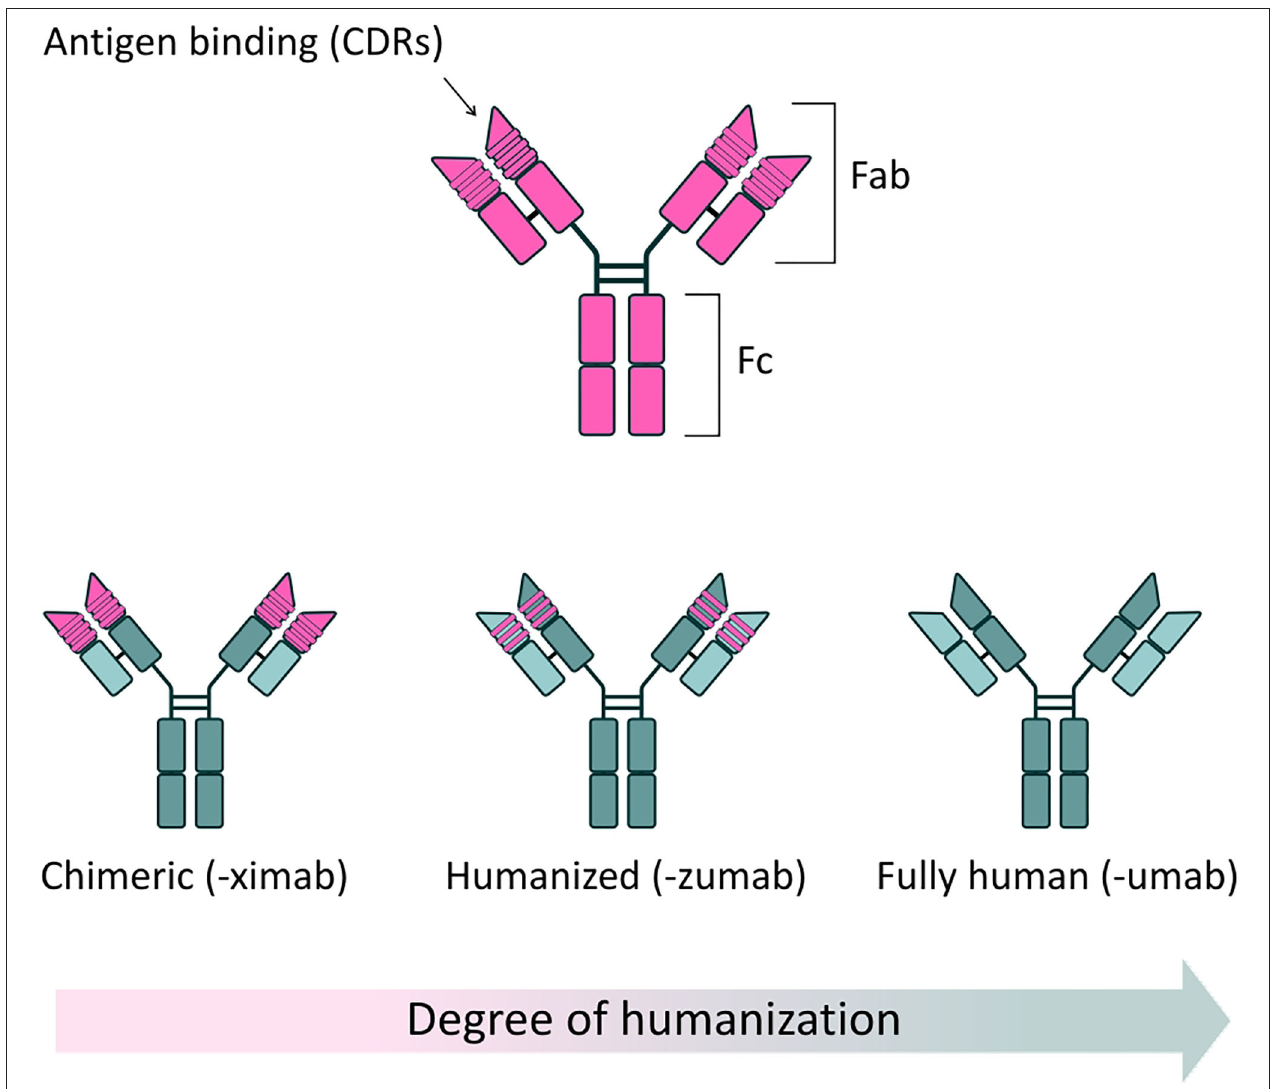
FIGURE 1 | Full-length antibody structure. (Top) Schematic of a typical antibody structure, generated from a murine source. Two heavy chains and two light chains are connected in pairs by disulphide bonds. The fragment antigen binding (Fab) region contains highly variable complementarity determining regions (CDRs), responsible for the specific recognition and binding of antigens. The fragment crystallizable (Fc) region binds to specific receptors on immune cells, modulating the immune response, as well as some proteins of the complement system. (Bottom) Reduced immunogenicity of mAbs through protein engineering. The clinical success of mAbs has largely been driven by application of protein engineering techniques, which have allowed the development of safer, less immunogenic structures, when compared to mAbs of solely murine origin. Chimeric antibodies are characterized by approximately one third of their structure being derived from the original murine source. In these antibodies, murine-derived variable regions are linked to a human constant domain scaffold. By convention, chimeric mAbs are named using the “-ximab” suffix. In humanized mAbs, 90% of the structure is of human origin, with only the antigen binding sites deriving from the original mouse source. Humanized mAbs are named using the “-zumab” suffix. Fully human mAbs are entirely derived from human sources and thus display minimal immunogenicity in clinical use. Fully human antibodies are named using the “-umab”